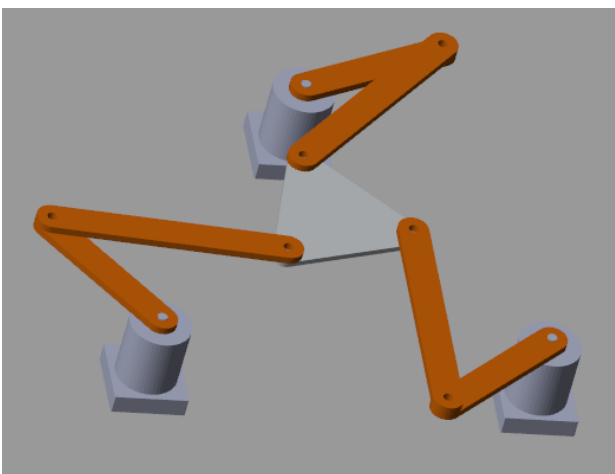
Figure 2. The 3D CAD model of the parallel manipulator. Table 1. The robot parameters.